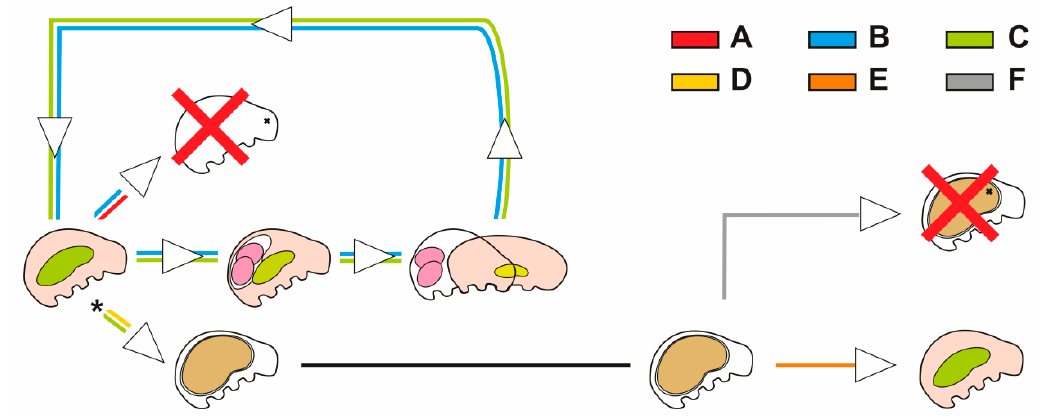
Figure 1. Scheme of the general behavior pathways related to cyst dynamics. ( A ) Animal’s death within a few days of being transferred to a low temperature; ( B ) animal’s death after one or several reproductive cycles since being transferred to a low temperature; ( C ) cyst formation by specimens which have undergone one or several reproductive cycles since being transferred to low temperature; ( D ) cyst formation by specimens that have not reproduced since being transferred to low temperature; ( E ) leaving the cuticular capsule / free-living animal; ( F ) animal’s death before the cuticular capsule abandonment. Period of reproduction arrest (asterisk).